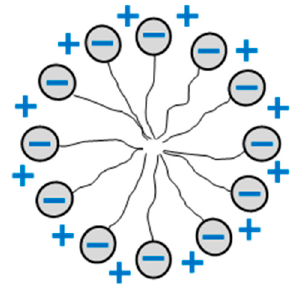
Figure 2. Schematic illustration of an anionic surfactant micelle in solution.